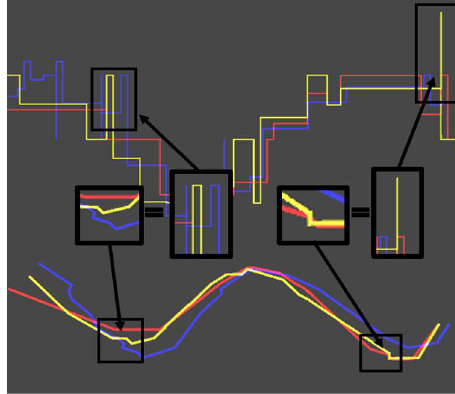
Fig. 18 RP, OP and SP, and their respective turning functions V. R